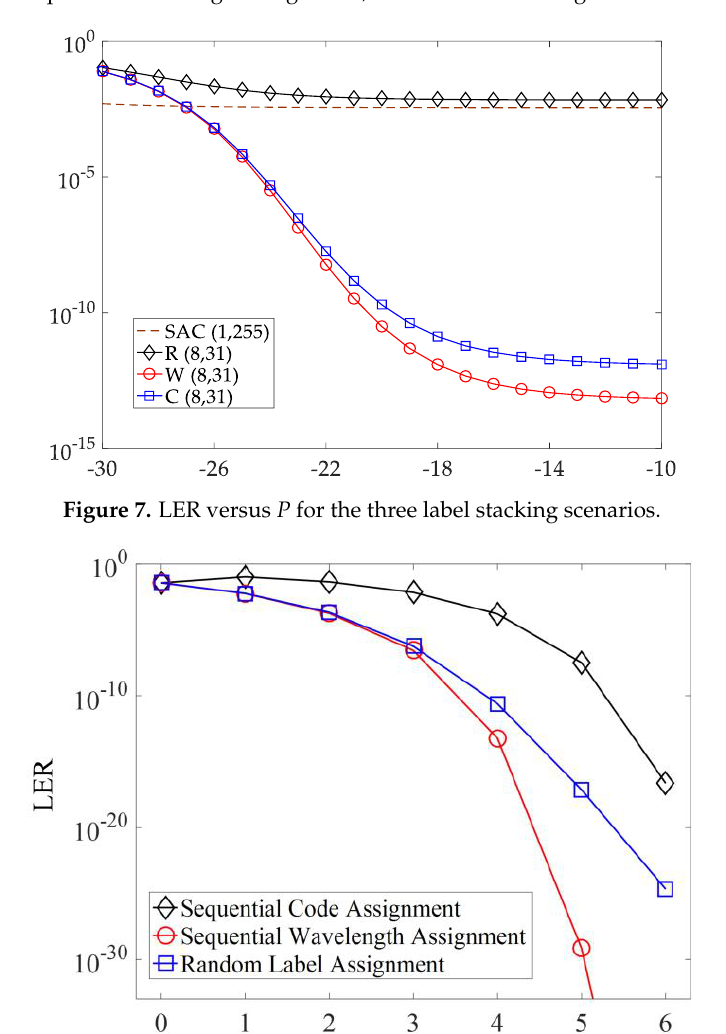
Figure 7. LER versus P for the three label stacking scenarios.